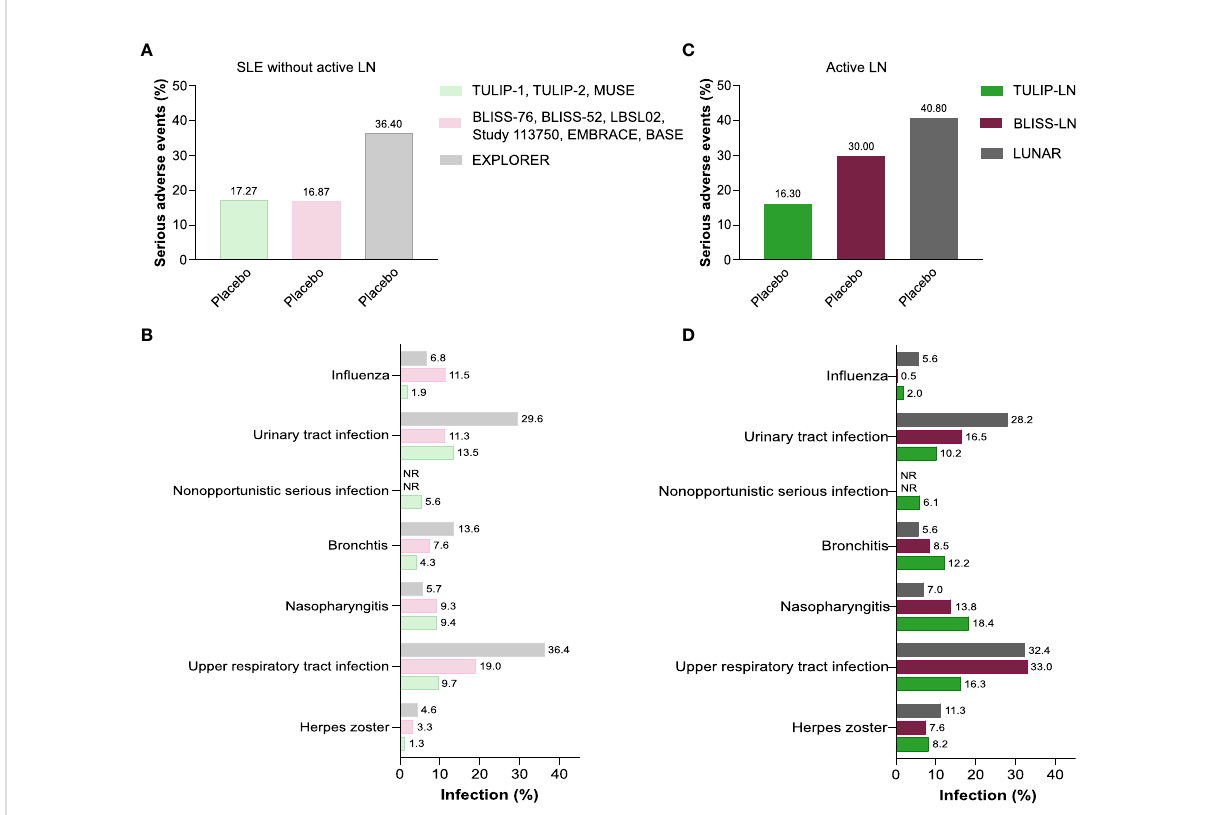
FIGURE 2 Infectious complications in standard-of-care placebo group in SLE without versus with active LN trials. (A) Percentage of serious adverse events in patients receiving placebo in the systemic lupus erythematosus (SLE) without active LN trials that are reported in the anifrolumab (TULIP-1, TULIP-2, MUSE), belimumab (BLISS-76, BLISS-52, LBSL02, Study 113750, EMBRACE, BASE) and rituximab (EXPLORER) trials. (B) Prevalence of herpes zoster, upper respiratory tract infection, nasopharyngitis, bronchitis, nonopportunistic serious infection, urinary tract infection, and in fl uenza in patients receiving placebo in the SLE without active LN trials as listed in (A) . (C) Percentage of serious adverse events in patients receiving placebo in the active lupus nephritis (LN) trials that are reported in the anifrolumab (TULIP-LN), belimumab (BLISS-LN) and rituximab (LUNAR) trials. (D) Prevalence of herpes zoster, upper respiratory tract infection, nasopharyngitis, bronchitis, nonopportunistic serious infection, urinary tract infection, and in fl uenza in patients receiving placebo in the SLE without active LN trials as listed in (C). NR, not